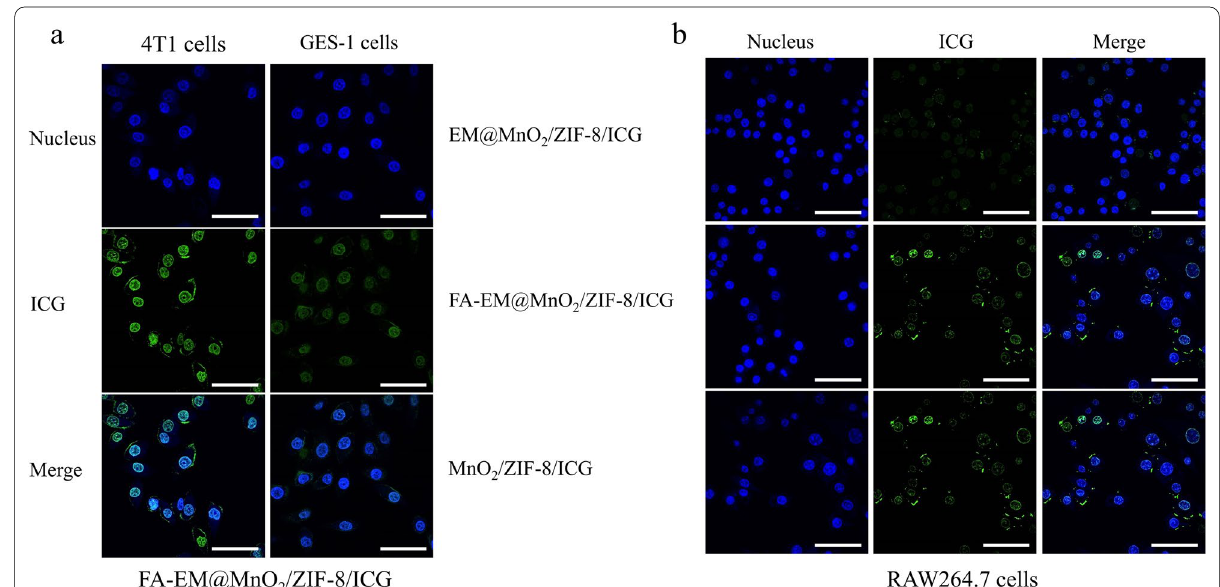
Fig. 3 a CLSM images of 4T1 and GES-1 cells incubated with FA-EM@MnO 2 /ZIF-8/ICG nano-platform for 3 h. b CLSM images of macrophage cells incubated with